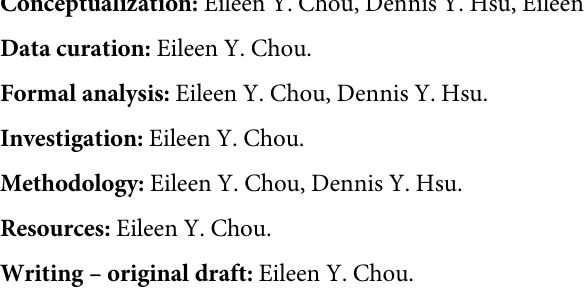
S1 Table. Percentage of volunteers by e-pledge condition per program in Study 1. S2 Table. Poisson regression analysis on hours